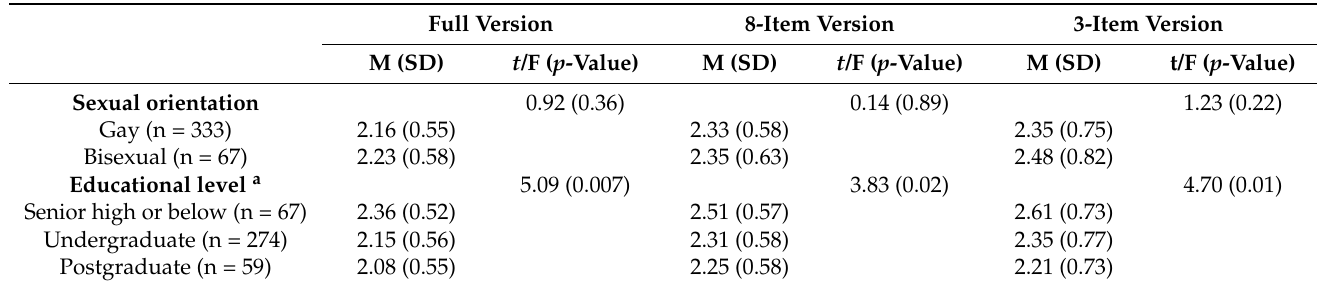
Table 5. Comparing the three versions of the UCLA Loneliness Scale (Version 3) between sexual orientation and educational level (N =